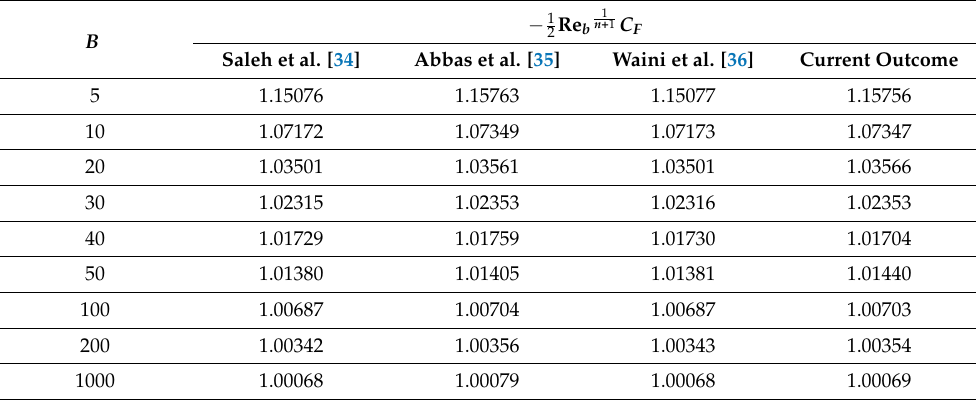
Table 2. Comparison of the skin friction coefficient results of